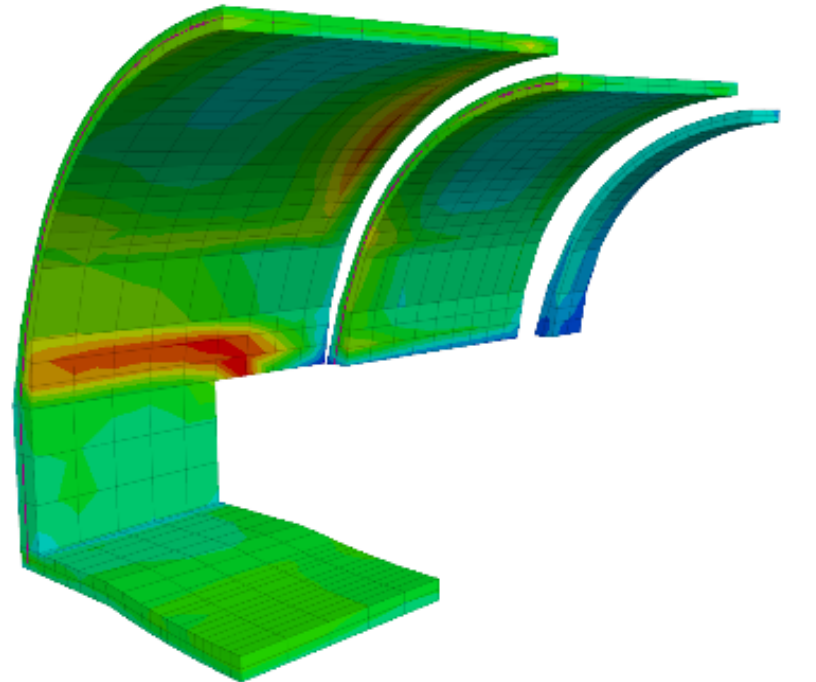
Figure 22. Minor principal stress contours (in N/m 2 ) in concrete elements. Minimum parameters.